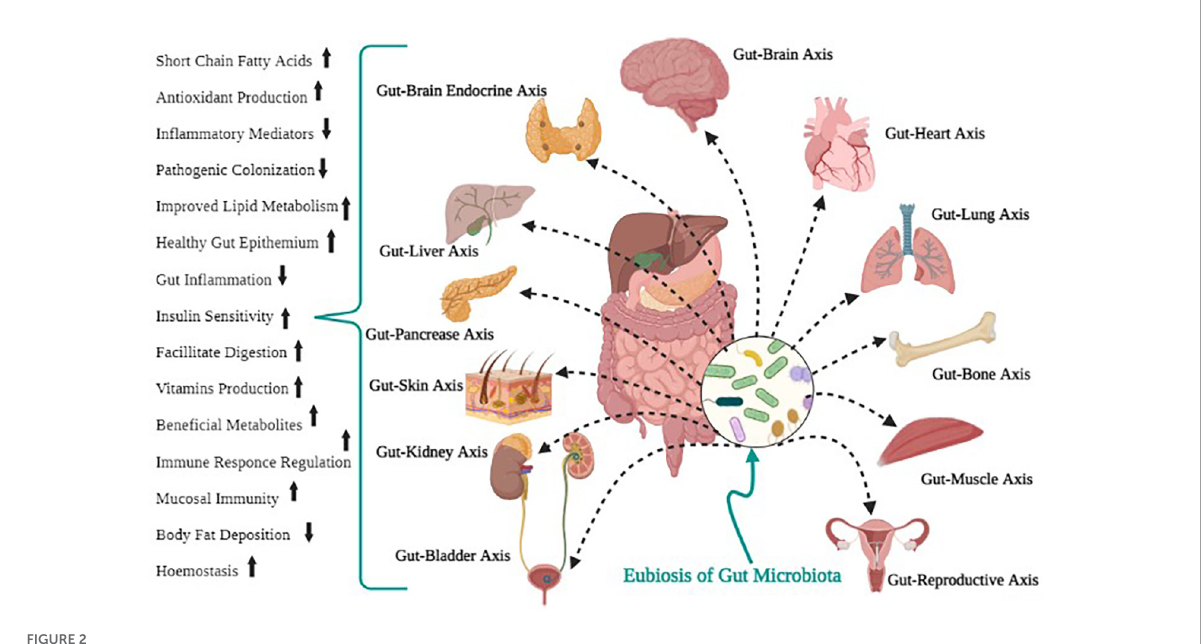
FIGURE2 Positive health outcomes of gut microbial